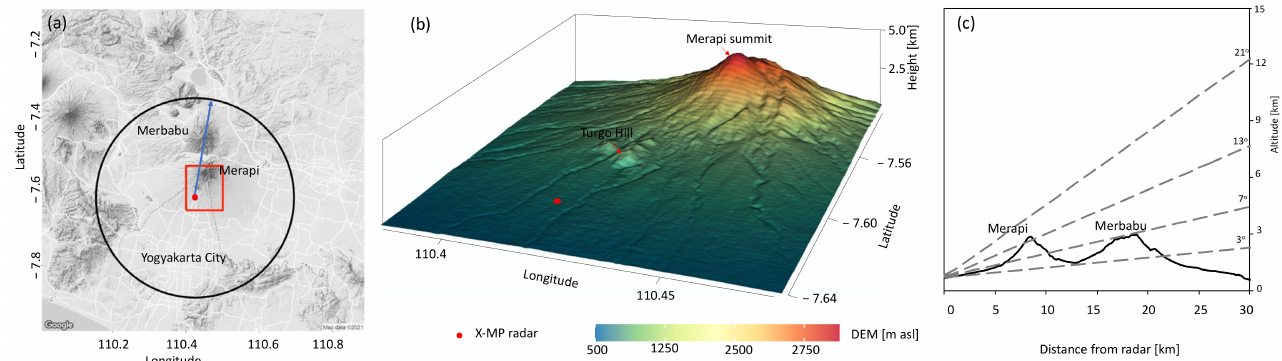
Figure 1. Left panel ( a ) is a fixed observation area of the PPI scan mode. Centre panel ( b ) is the 3D view of surface topography of the red square area in ( a ). Right panel ( c ) is the vertical profile of radar scan and topography, extracted along the blue arrow in ( a ). Identified in ( a ) are locations of Yogyakarta city, Merapi, and Merbabu. The locations of Turgo hill and Merapi summit are pointed by red arrows in ( b ) and the X-MP radar site is indicated by a red dot in ( a , b